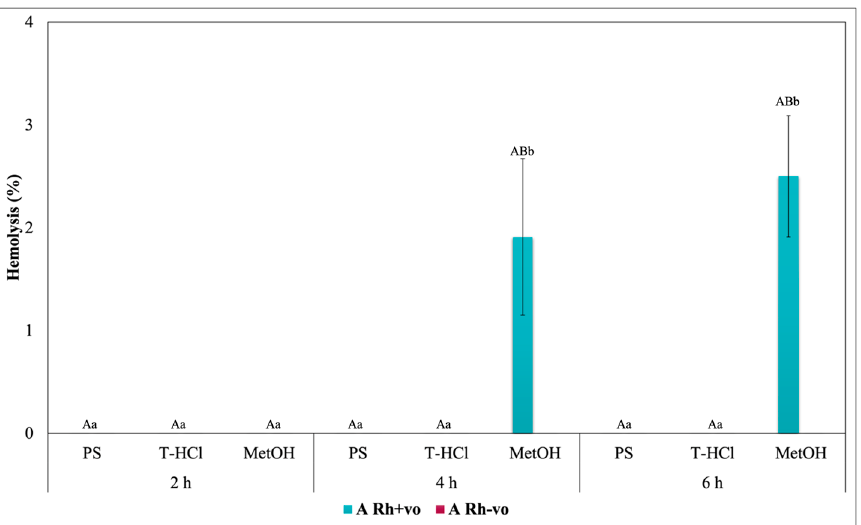
Figure 6. Blood biocompatibility assay of P. cruentum extracts on human erythrocytes with different RhD (positive and negative) of A blood group. Different letters represent significant differences in the means between treatments and groups ( p ≤ 0.001). Capital letters represent a two-way ANOVA. Lowercase letters represent a univariate ANOVA between extracts for each exposure period. PS, extract of physiological solution; T-HCl, 0.5 M Tris-HCl extract; MetOH, 99% methanol extract; AA, ascorbic acid; BCT, beta-carotene; FXA, fucoxanthin.